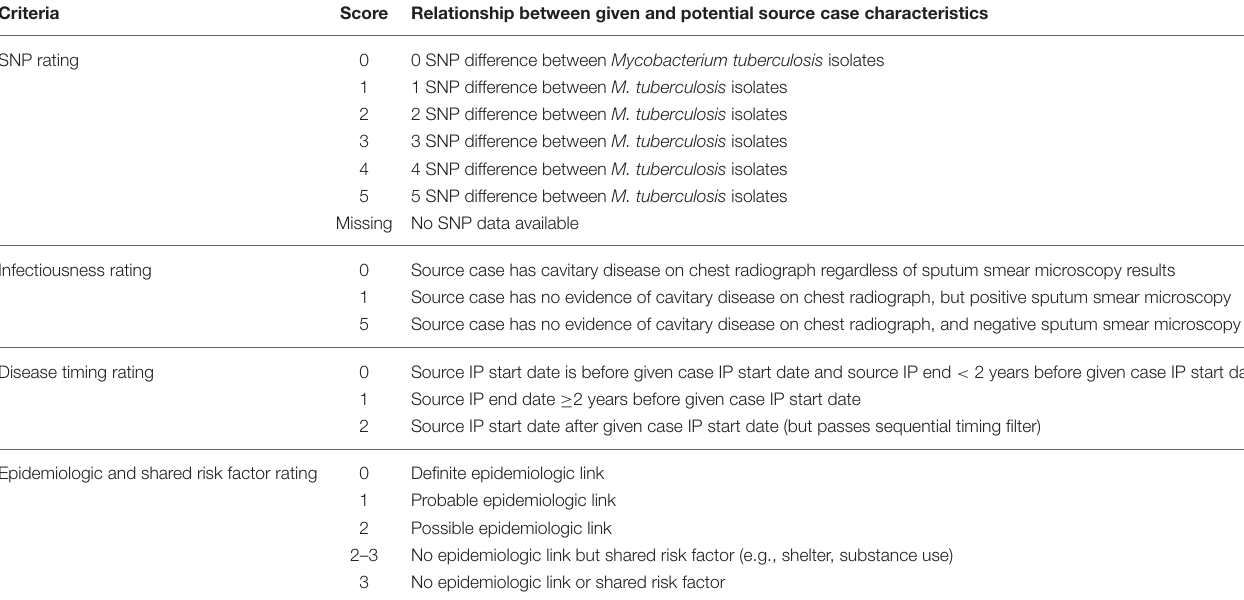
TABLE 1 | Logically Inferred Tuberculosis Transmission (LITT) scoring system used to rank potential tuberculosis (TB) source cases*. Criteria Score Relationship between given and potential source case